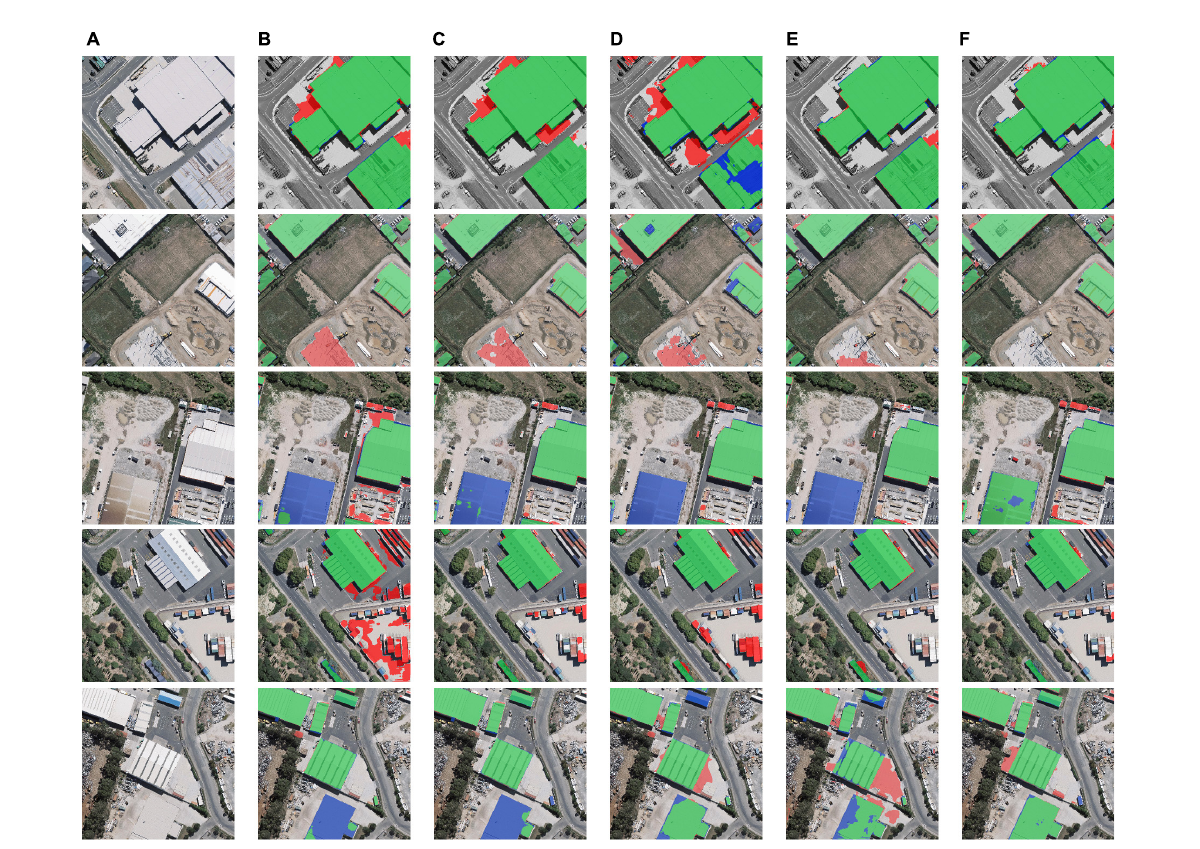
FIGURE9 Building extraction results: (A) original remote sensing image; (B) prediction of U-Net; (C) prediction of DeepLabv3+; (D) prediction of PSPNet; (E) prediction of DANet; (F) prediction of AttsegGAN (ours). Green: true positive (tp) pixels; transparent: true negative (tn) pixels; red: false positive (fp) pixels; blue: false negative (fn)